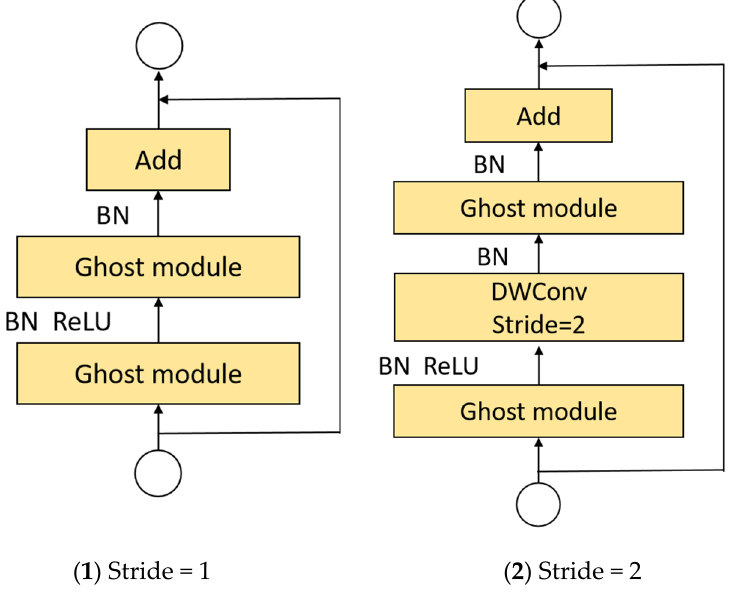
Figure 5. Structure of the Ghost ‐ BottleNeck.